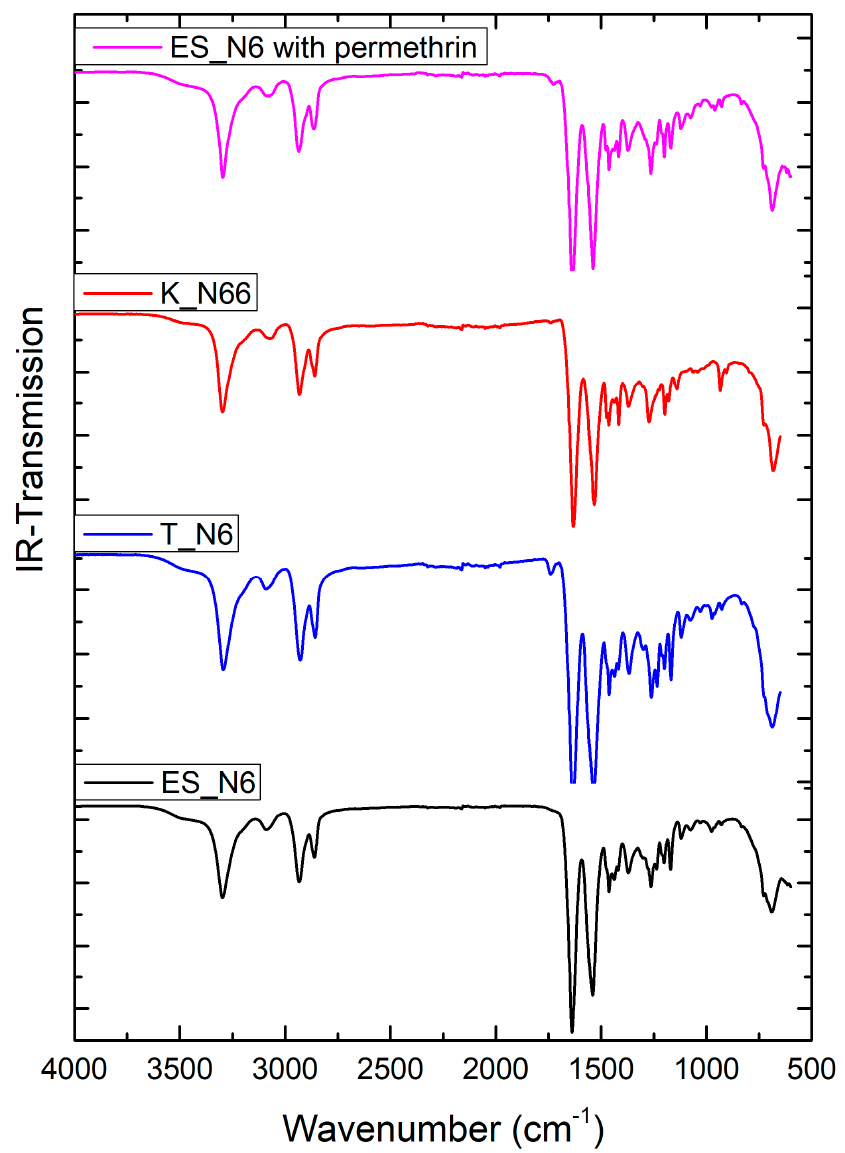
Figure 3. FTIR spectra of polyamide samples.